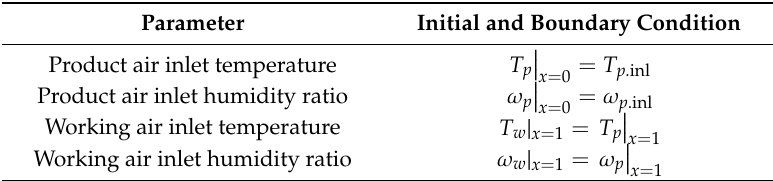
Table 1. Initial and boundary conditions applied to solve the mathematical model.